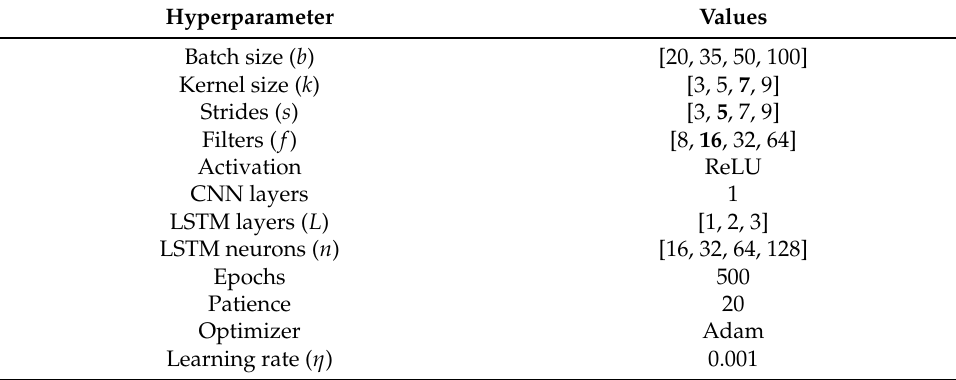
Table 2. Initial hyperparameter values for modeling. Single final values for k , s , and f were selected in Step 1 and specified in bold font. Values of b , L , and n were determined with Steps 2 and 3 depending on the d